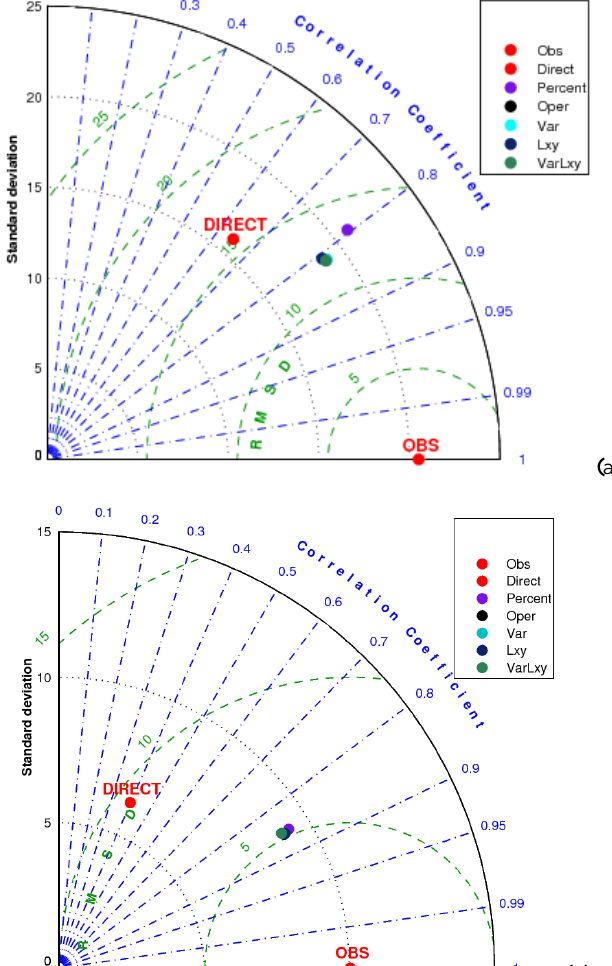
Fig. 10. Taylor diagram for several experiments studied, statistics averaged in the period between 1 and 10 July 2010 (a) and 1 and 10 December 2010 (b) for validation stations.